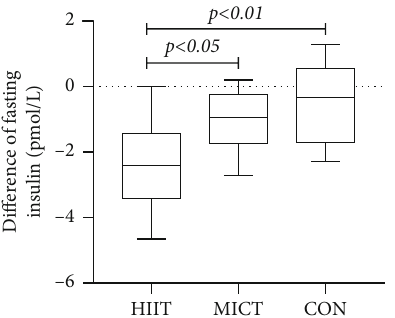
Figure 8: Di ff erence in fasting insulin levels in each group after